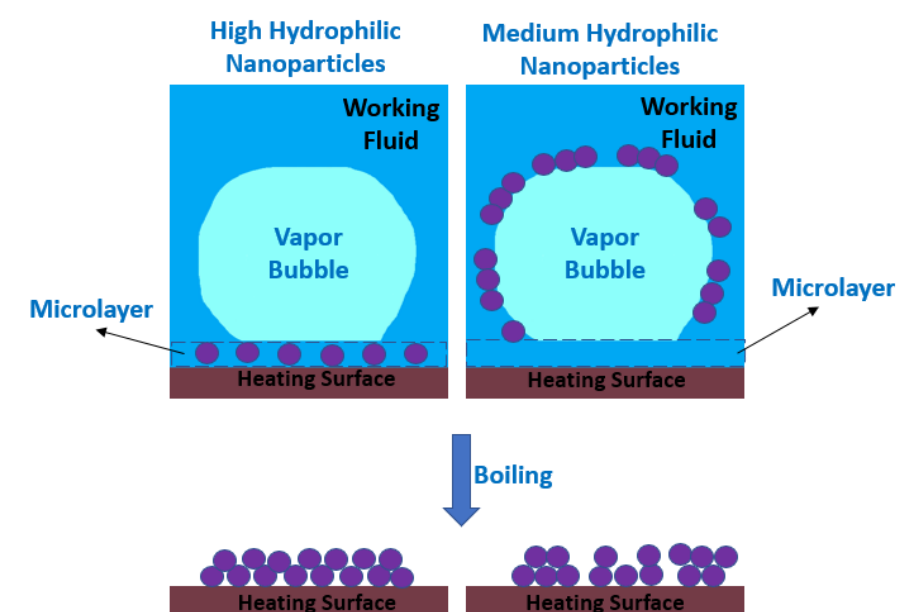
Figure 10. Nanoparticle hydrophilicity effect on the deposited layer morphology.